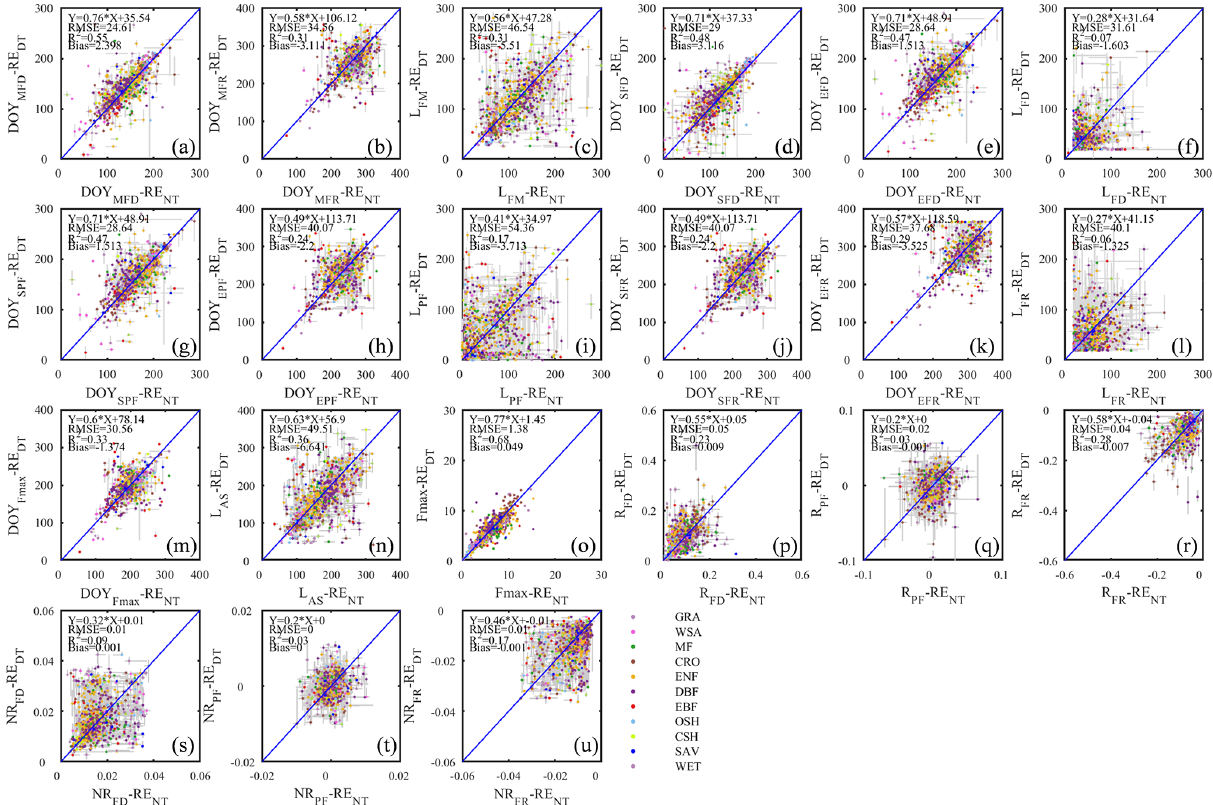
Figure 7. The scatter plots of seasonality metrics from RE data using daytime and nighttime partitioning